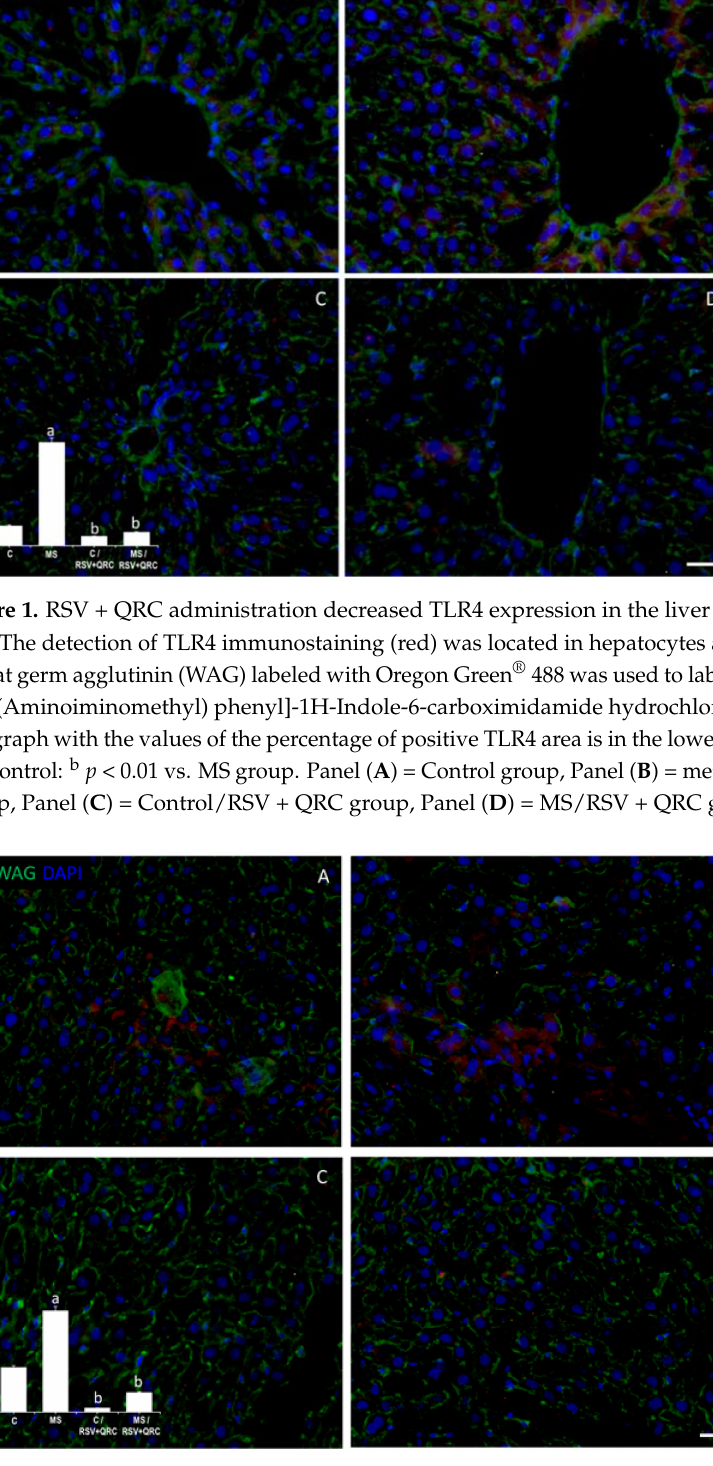
Figure 2. Effect of the administration of natural compounds on Neutrophil elastase (NE) immunode- tection. The detection of NE immunostaining (red) was located in regions away from the lumen of the vessels. Wheat germ agglutinin (WAG) labeled with Oregon Green ® 488 was used to label the membranes and DAPI for nuclei. The graph with the values of the percentage of positive NE area is in the lower-left corner. a p < 0.05 vs. Control: b p < 0.01 vs. MS group. Panel ( A ) = Control group, Panel ( B ) = metabolic syndrome (MS) group, Panel ( C ) = Control/RSV + QRC group, Panel ( D ) = MS/RSV + QRC group. Bar = 50 µ